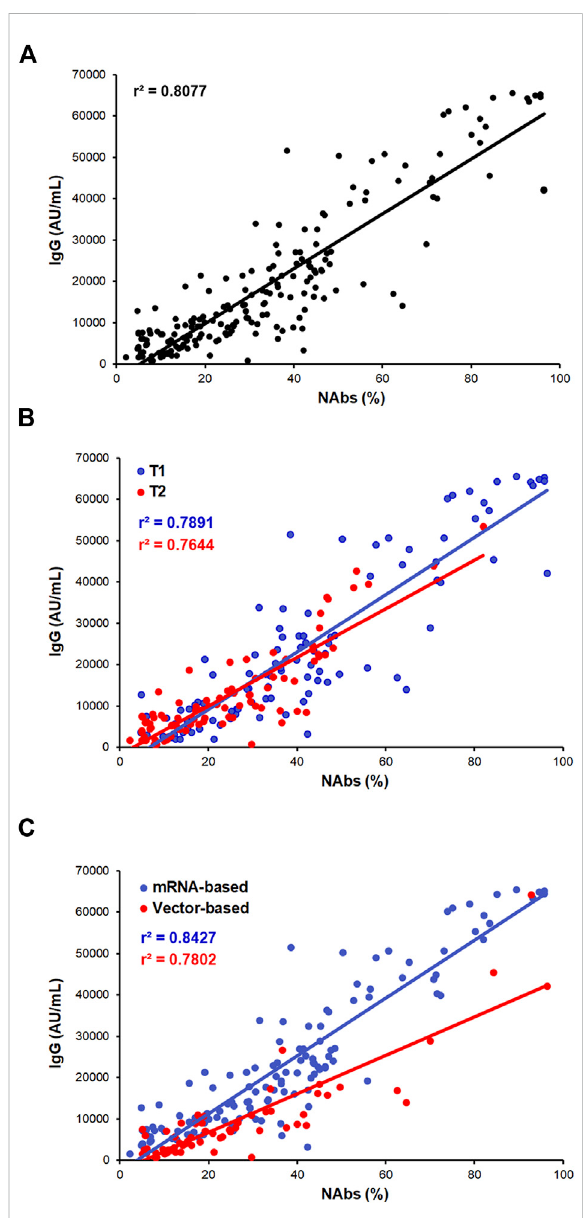
FIGURE 2 IgG and NAbs correlation analysis. (A) Correlation between IgG and NAbs level distributions in the whole cohort of subjects. (B) Correlation between IgG and NAbs strati fi ed by T1 and T2 (T1: blue dots/line and T2: red dots/line). (C) Correlation between IgG and NAbs strati fi ed by vaccine formulation (mRNA-based vaccine: blue dots/line and vector-based vaccine: red dots/line). Each panel shows the speci fi c regression line and r -coef fi cient.